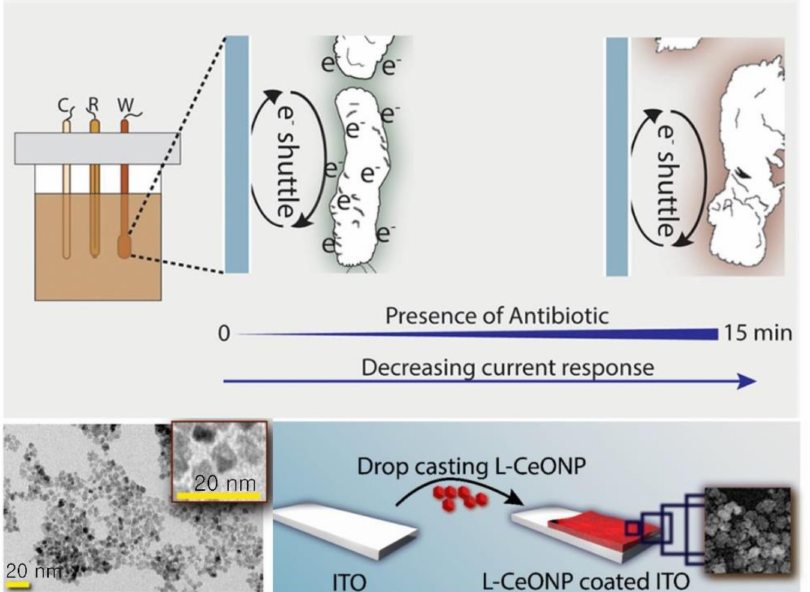
Figure 3. Electrochemical antibiotic susceptibility testing strategy based on monitoring current response caused by changed membrane properties. L-lysine coated cerium oxide nanoparticle (L-CeONP) coated indium tin oxide (ITO) electrode for determining the resistance level of E. coli against ciprofloxacin, cefixime, and amoxycillin. Adapted with permission form [57]. Copyright 2020 American Chemical